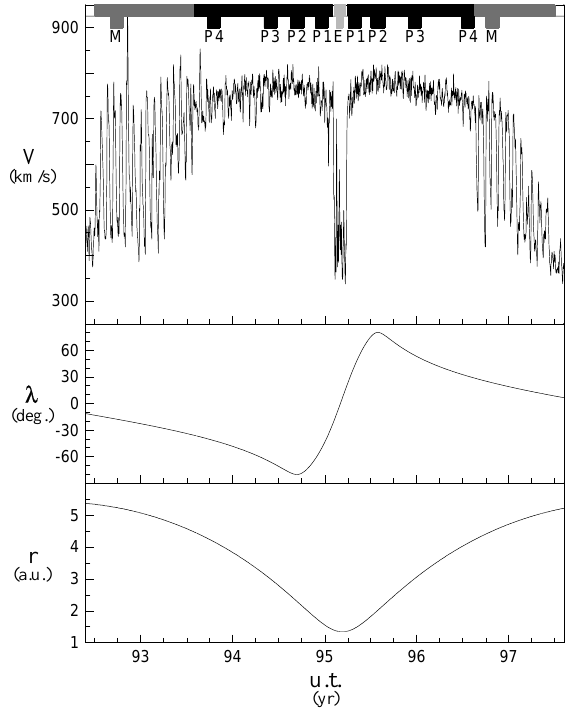
Fig. 1. The solar wind velocity V (in km/s) and the Ulysses heli- ographic latitude λ (in degrees) and heliocentric distance r (in as- tronomical units, a.u.) are plotted vs. universal time (u.t.) for the investigated interval.